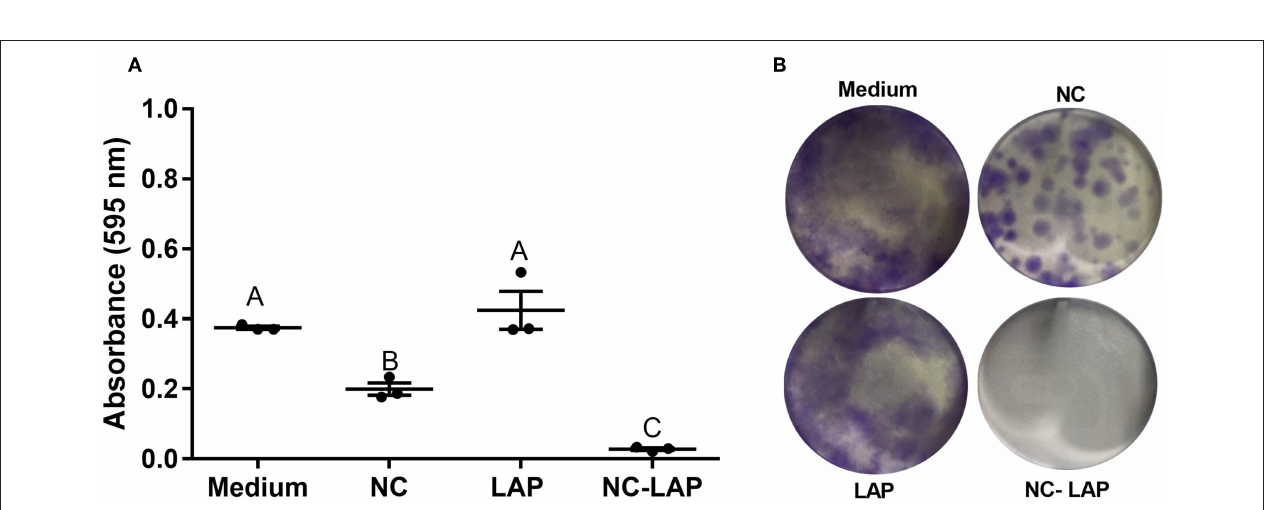
FIGURE 5 | NC-LAP inhibited the T24 cells colony formation. Cells were treated with LAP or NC-LAP at 5 µ M, as well as the relative amount of NC for 48h. (A) Shows absorbance relative to each well and (B) shows photographs of representative clonogenic assay plates. Data are represented by the mean ± SEM from three independent experiments. One-way ANOVA with Tukey post-hoc was used to analyze statistical significance. Different letters indicate significant differences between the means. Significance was considered at P <